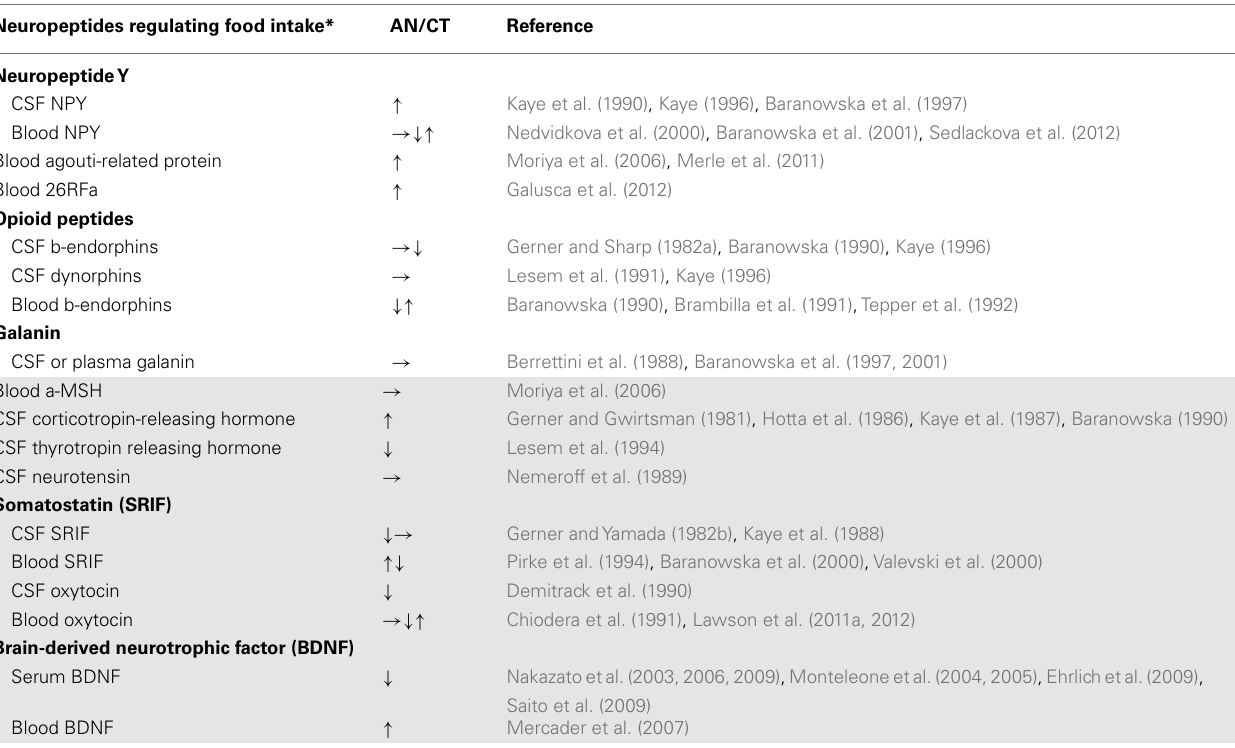
Table 3 | Compared levels of neuropeptides regulating food intake inAN patients and healthy matched